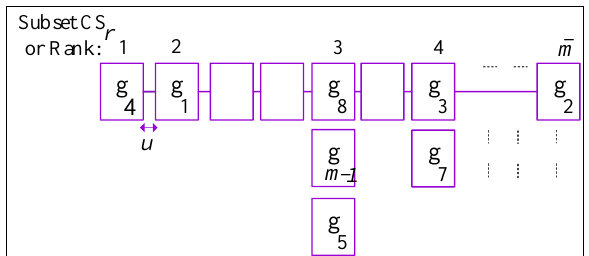
Figure 3. Schematic of sample cards played by DM during the SIMOS procedure [36].